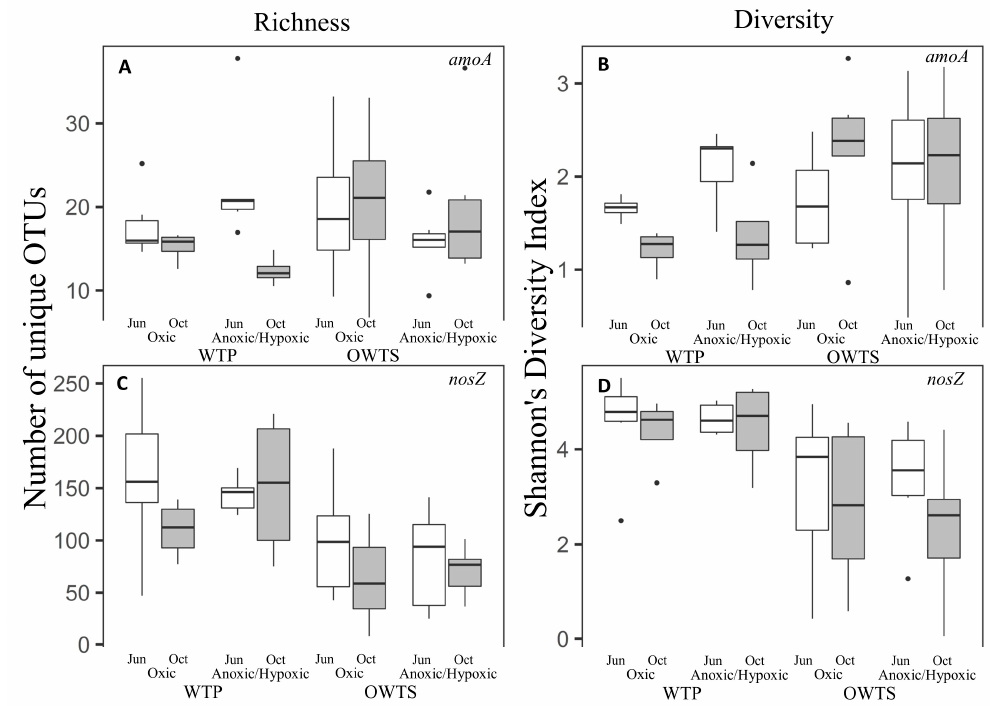
Figure 1. amoA Species richness ( A ) and Shannon’s diversity index ( B ), and nosZ species richness ( C ) and Shannon’s diversity index ( D ) in the oxic and anoxic compartments of a wastewater treatment plant (WTP) and of onsite wastewater treatment systems (OWTS)—both with biological N removal—in June (white box) and October 2016 (grey box). amoA : n = 5–7 for WTP and 5–8 for OWTS; nosZ : n = 5–7 for WTP and 5–9 for OWTS.